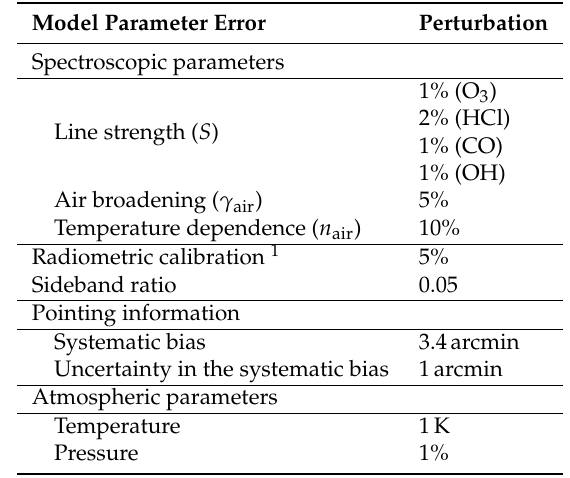
Table 2. Model parameter errors considered in the TELIS FIR retrievals. For each error, the corresponding perturbation amount is indicated in the right column. See the text for a detailed explanation of each error